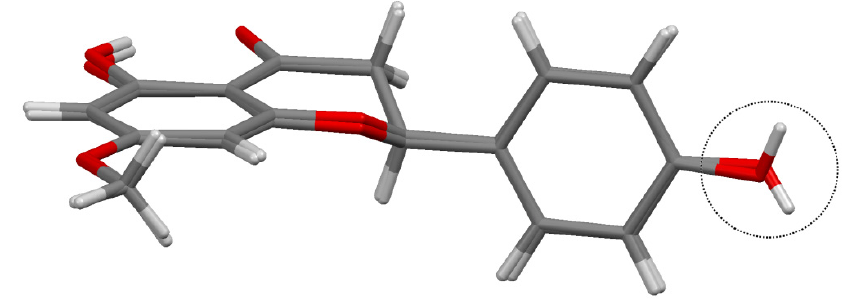
Figure 3. Superimposed structures for the sakuranetin-anhydrous and sakuranetin-dihydrate forms.